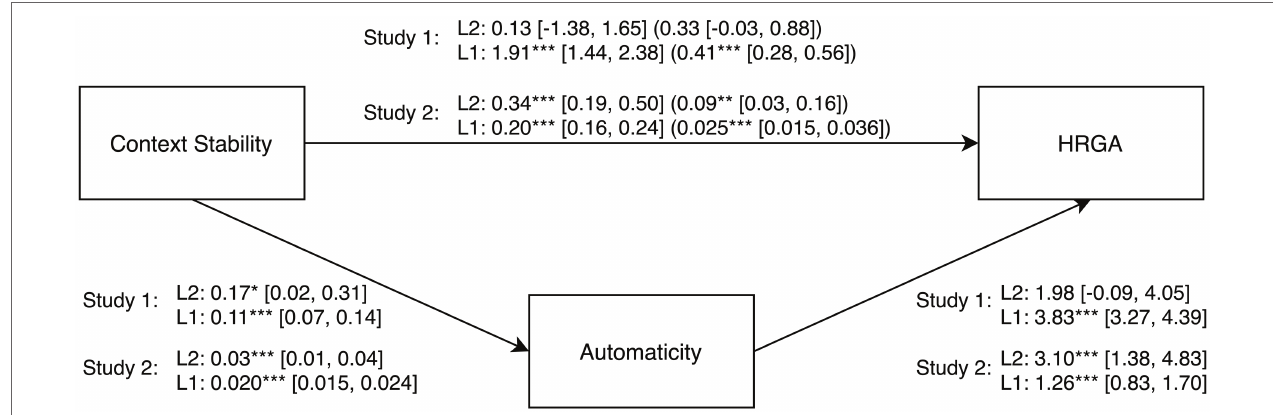
FIGURE 1 | Multilevel mediation analysis with unstandardized regression coefficients of the effect of context stability on HRGA (habit repetition goal attainment) through automaticity. The first coefficients on the path from context stability to HRGA represent the direct effect without the mediator; the coefficients in parentheses on this path represent the indirect effects with the mediator included in the model. The random intercepts were significant for both automaticity (Study 1: variance u 0automaticity = 4.21*** [3.12, 5.68]; Study 2: variance u 0 automaticity = 3.41*** [2.68, 4.34]), and HRGA (Study 1: variance u 0 HRGA = 407.69*** [296.76, 560.08]; Study 2: variance u 0 HRGA = 491.90*** [389.32, 621.52]). Level 2 (L2) = person-level (Study 1)/habit-level (Study 2); Level 1 (L1) = habit repetition level. 95% confidence intervals are in brackets. * p < 0.05, ** p < 0.01, *** p <